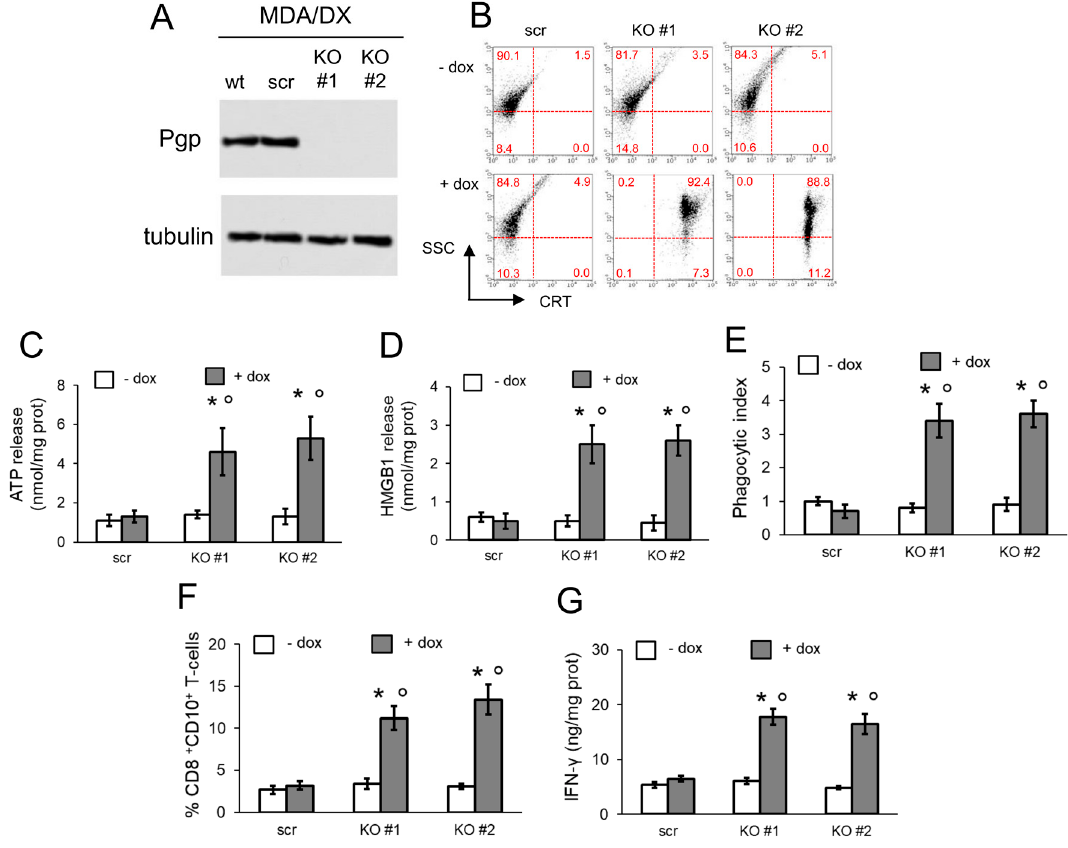
Figure 5. Pgp knock-out restores doxorubicin-induced immunogenic cell death. MDA-MB-231/DX cells (wild type, wt) were transduced with a non-targeting vector (scrambled vector; scr) or with two CRISPR pCas Pgp-targeting vectors (KO#1, KO#2). Cells were grown in fresh medium (- dox) or